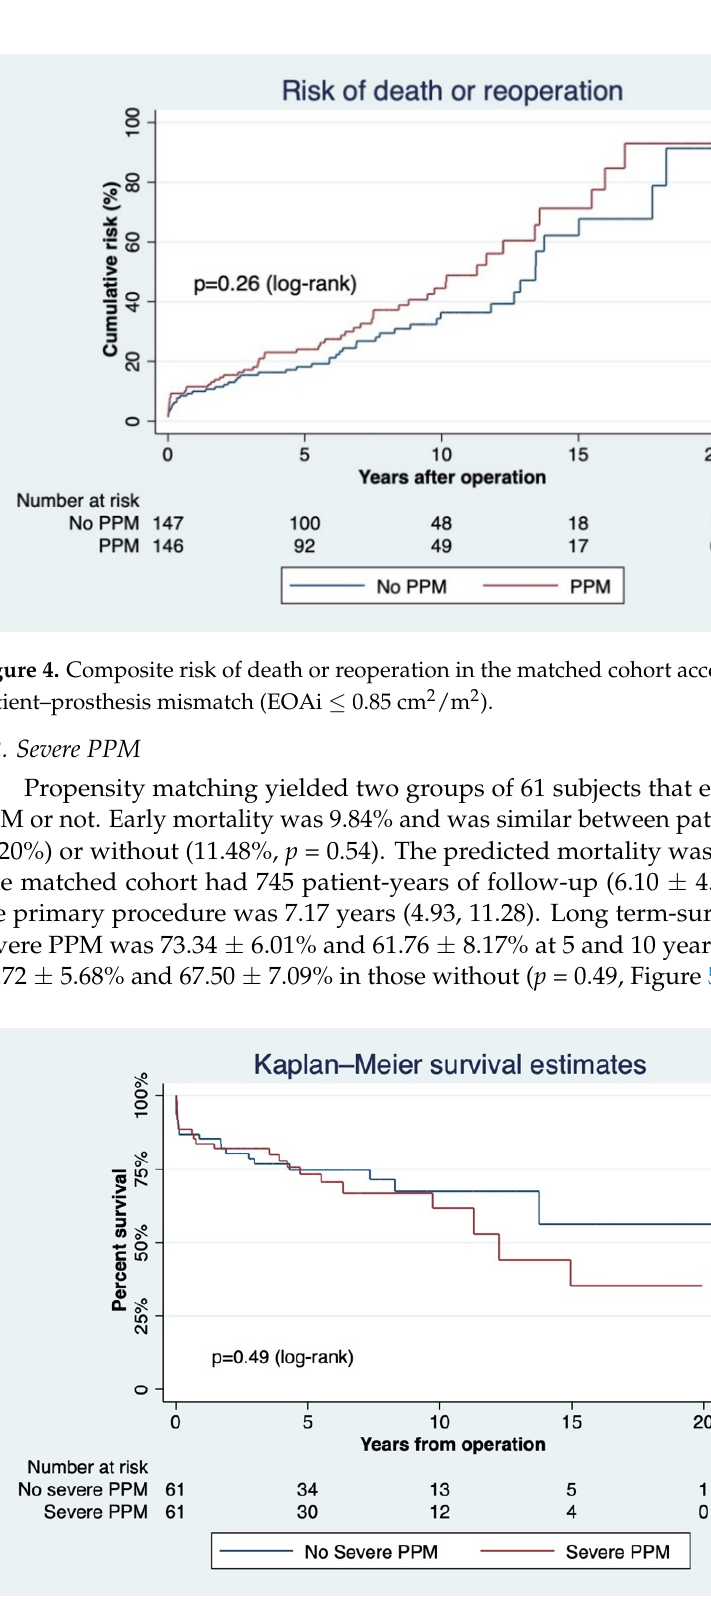
Figure 5. The effect of severe patient–prosthesis mismatch (EOAi ≤ 0.65 cm 2 /m 2 ) on long-term survival. Independent risk factors for mortality within the matched population included only older age when severe PPM was added to the multivariate model (Figure 3). The Schoenfeld residuals test returned a probability of 0.83 for the proportionality assumption to be met